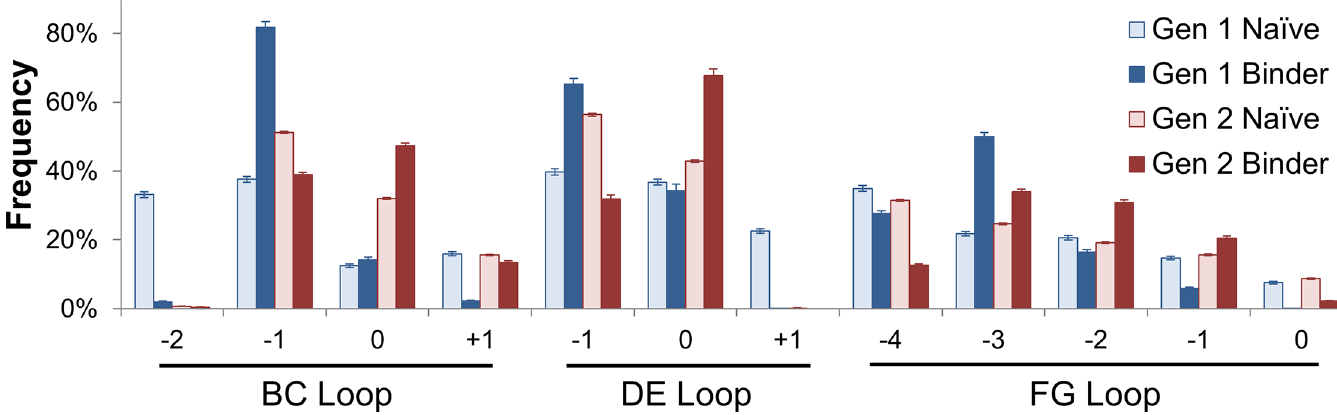
Fig 4. Loop length variation. Loop length frequencies in na ï ve and binder populations as identified by Illumina sequencing of first and second generation (details in Table 3). Bars and error bars represent mean ± standard